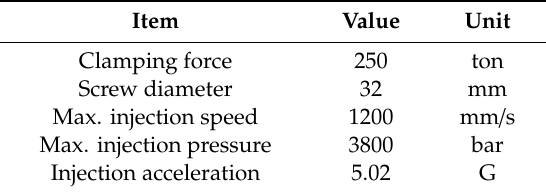
Table 3. Process conditions and levels for molding